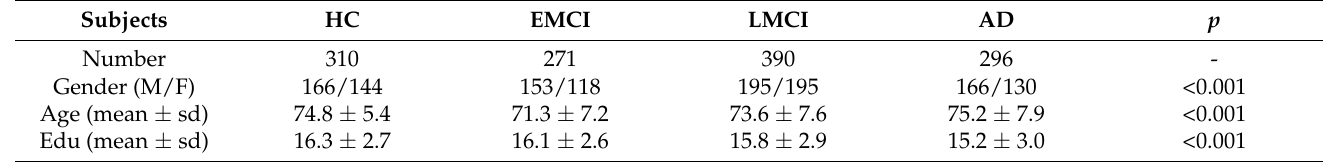
Table 1. Participant characteristics. HC = healthy control; EMCI = Early Mild Cognitive Impair- ment; LMCI = Late Mild cognitive Impairment; AD = Alzheimer’s disease; M/F = male/female; Edu = education; sd = standard deviation; p = p -value calculated by t